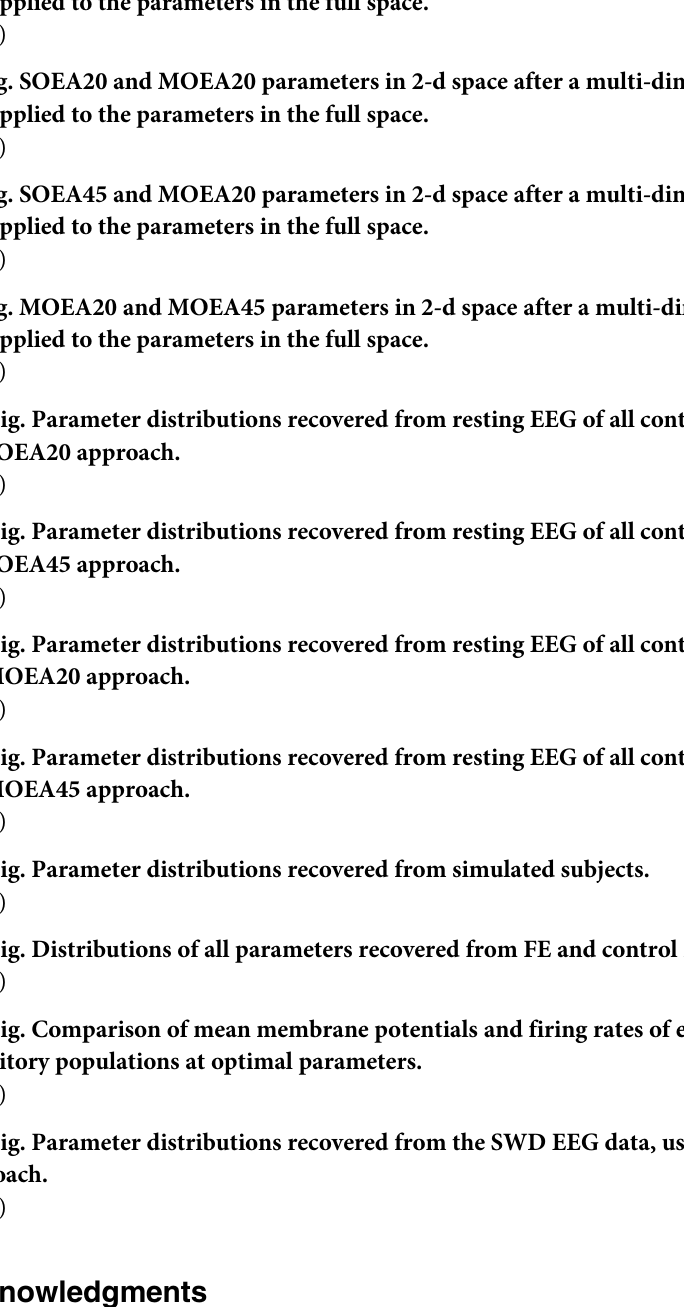
S17 Fig. Parameter distributions recovered from the SWD EEG data, using the MOEA20